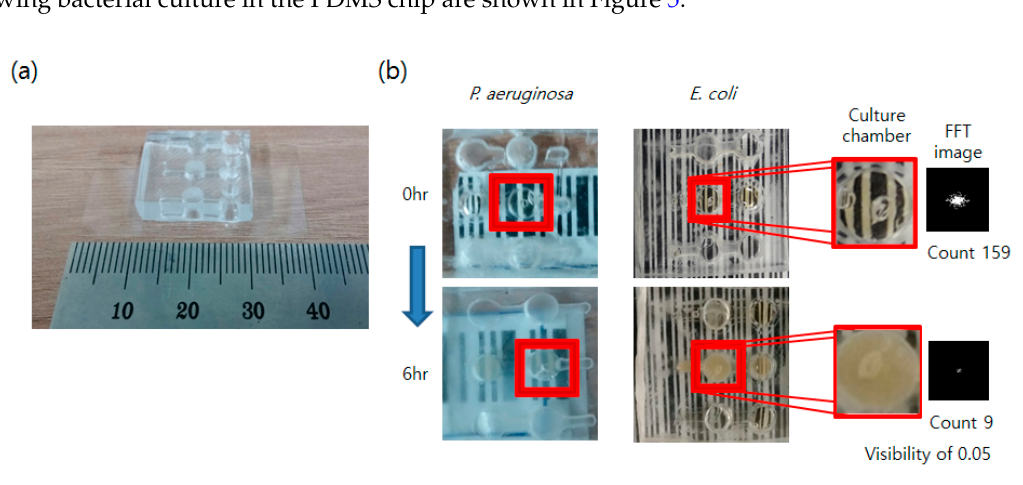
Figure 5. Usage of PDMS devices for bacterial growth. ( a ) PDMS device is fabricated and used for the bacterial culture (Imaged with 40 mm marked ruler). ( b ) The growth of P. aeruginosa (left) and E. coli (right) in the culture chamber of the PDMS device is shown. The FFT spectrum of the red-squared region (culture chamber on the marker) shows a decrease in the high-frequency region as time passes due to bacterial growth.